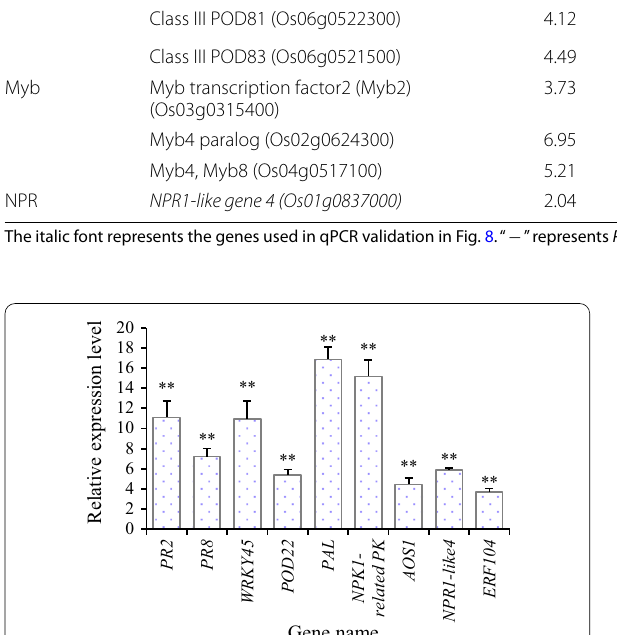
Fig. 8 PR genes with EsxA-induced up-regulated transcription levels. The italic font in Table 1 represents the genes used in qPCR validation; “**” above the column indicates the differences between E48 and Con48 were significant ( P <